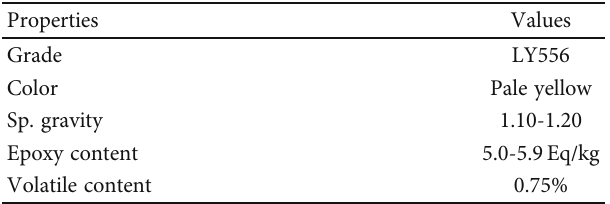
Table 2: Properties of epoxy resin.